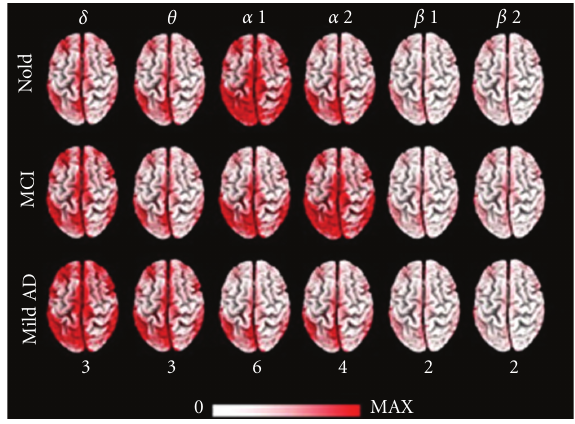
Figure 1: Grand average of low-resolution brain electromagnetic source tomography (LORETA) solutions (i.e., normalized relative current density at the cortical voxels) modeling the distributed EEG sources for delta, theta, alpha 1, alpha 2, beta 1 (13– 20Hz), and beta 2 (20–30Hz) bands in normal elderly (Nold), mild cognitive impairment (MCI) and mild Alzheimer’s disease (AD) groups. The left side of the maps (top view) corresponds to the left hemisphere. Legend: LORETA, low-resolution brain electromagnetic tomography. Color scale: all power estimates were scaled based on the averaged maximum value (i.e., alpha 1 power value of occipital region in Nold). The maximal value of power is reported under each